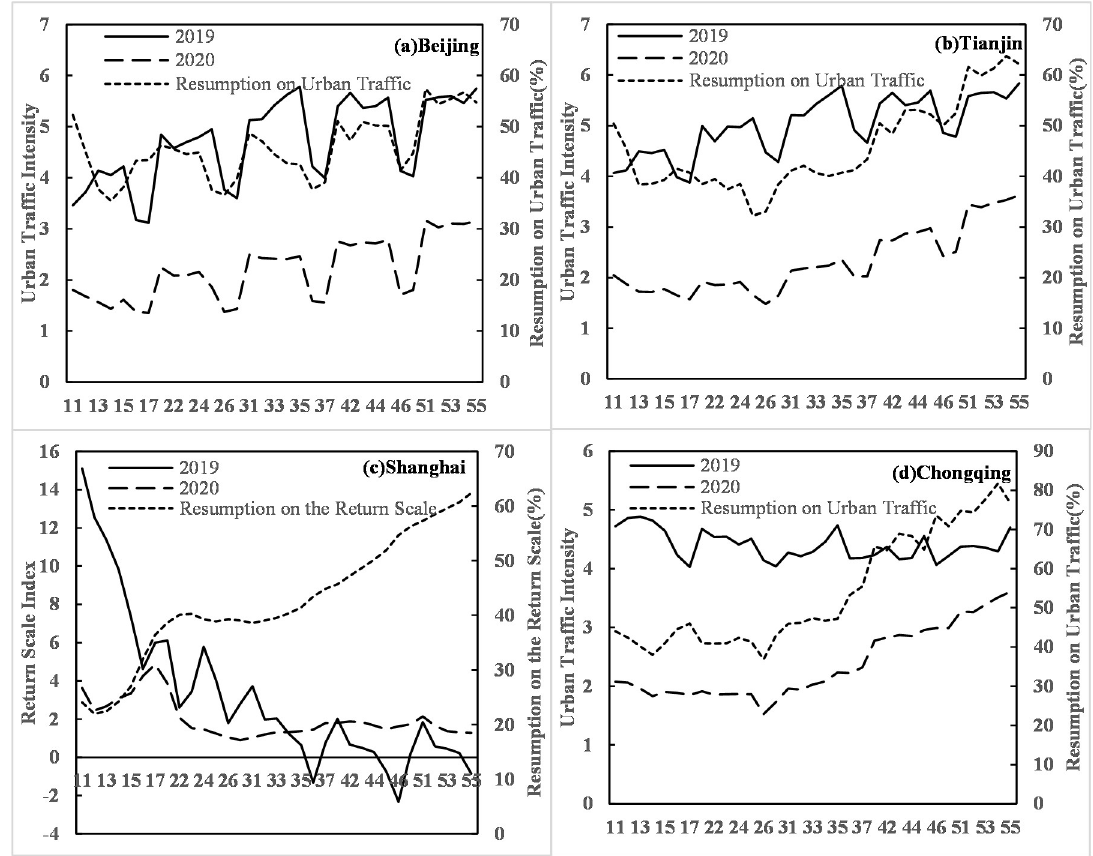
Fig 4. Daily changes in urban traffic intensity and the resumption of urban traffic in Beijing, Tianjin, Shanghai and Chongqing.